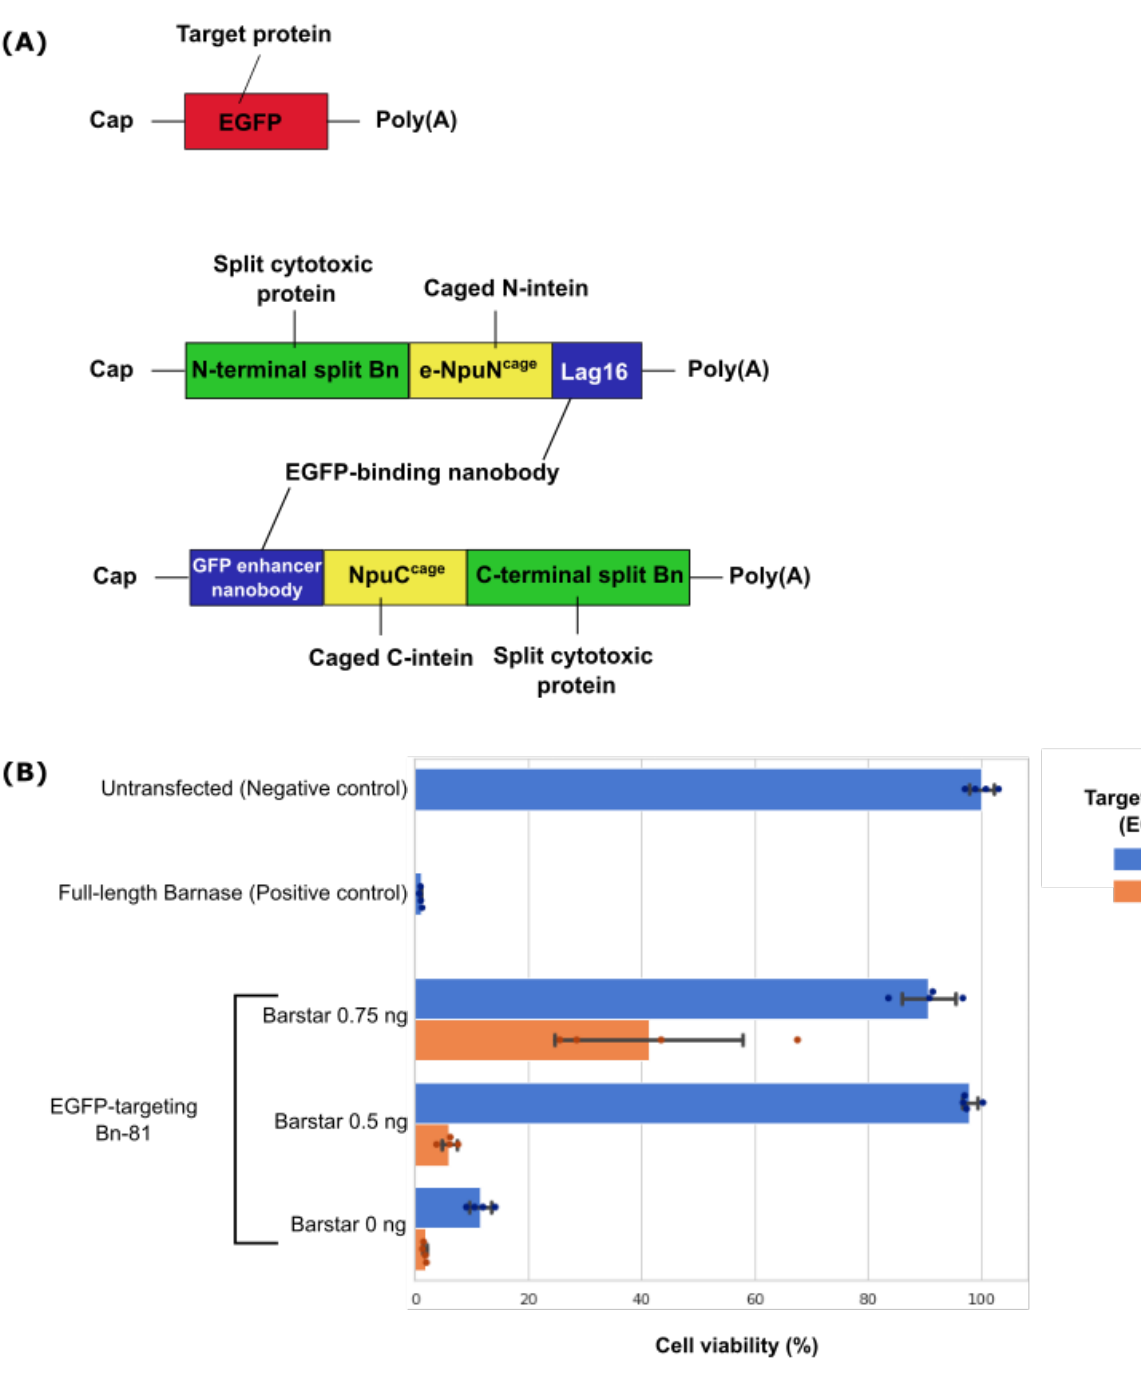
Figure 5. EGFP-targeting Bn-81 selectively eliminates target cells. ( A ) Schematic diagram of EGFP-targeting mRNAs used. All mRNAs were capped using CleanCap AG ( 3′ OMe). ( B ) Cell viability 2 days after cotransfecting HeLa cells with EGFP-targeting Bn-81 (45 ng/well of both N- and C-terminal split EGFP-targeting Bn-81), EGFP (10 ng/well), and Barstar mRNA (0.75, 0.5, or 0 ng/well). Full-length Bn (90 ng/well) was used as a positive control.